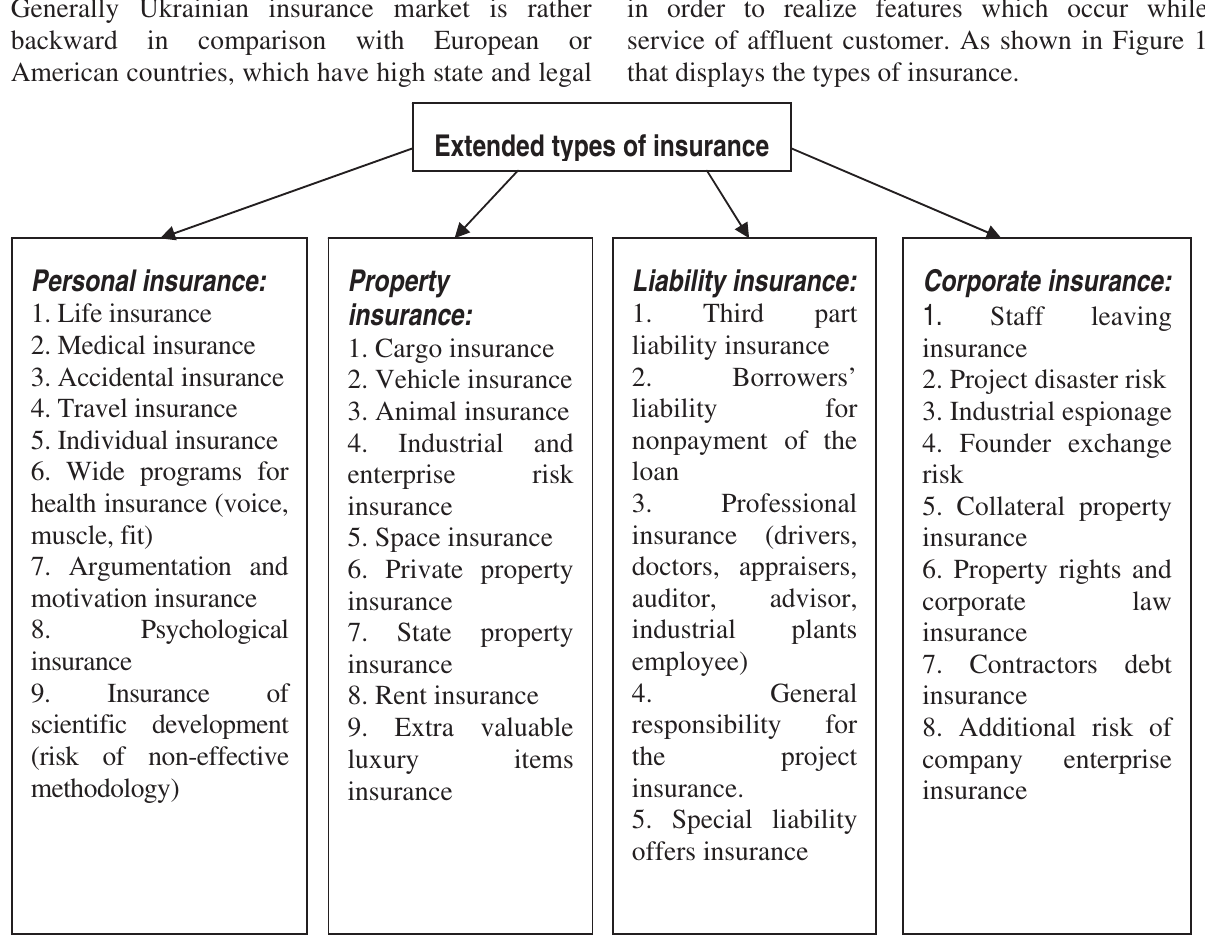
Fig. 1. Extended types of insurance for particular customers’